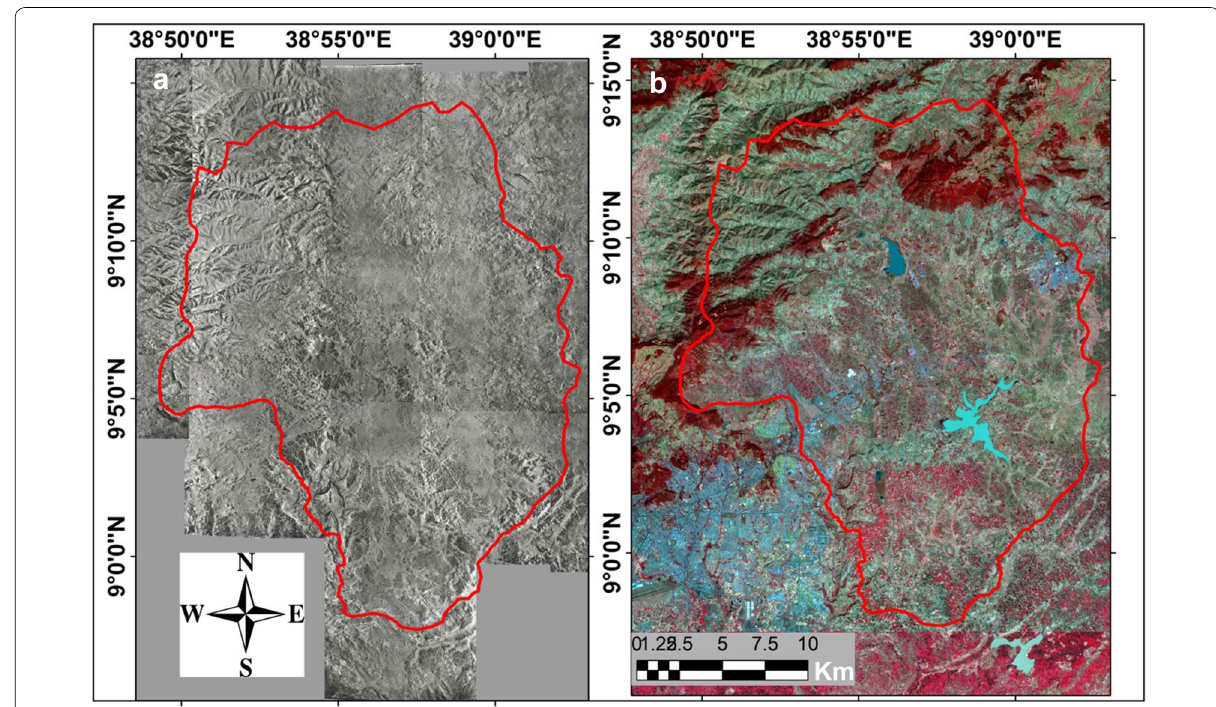
Fig. 2 Pre-processed aerial photographs a (1957) and Sentinel-2 image b